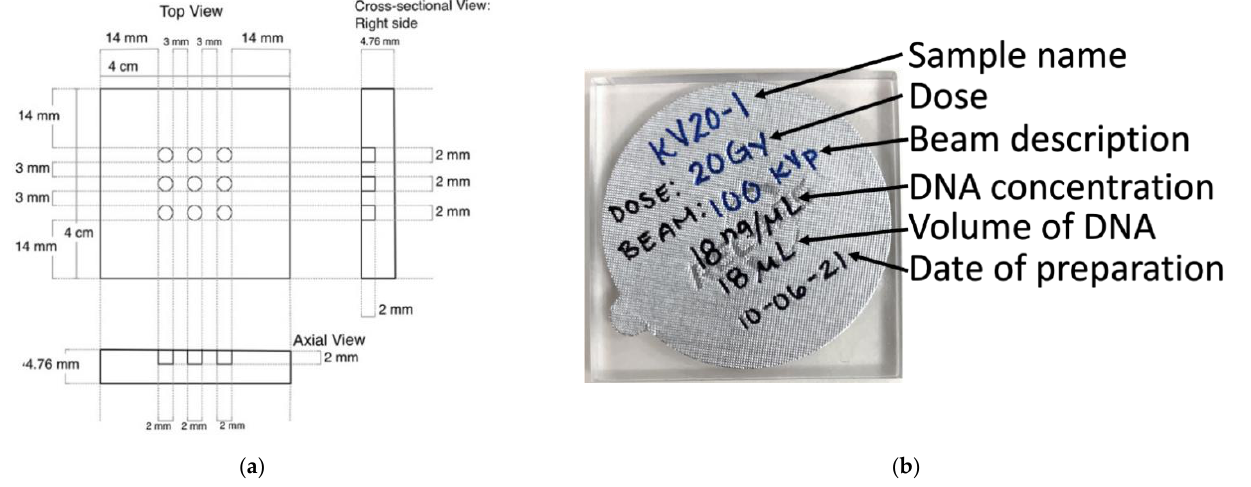
Figure 3. ( a ) Schematic of the DNA-based detector illustrating the position and size of the nine cavities that hold the DNA samples; ( b ) A sealed DNA-based detector ready for irradiation. Seal is covering wells containing DNA and has label information.